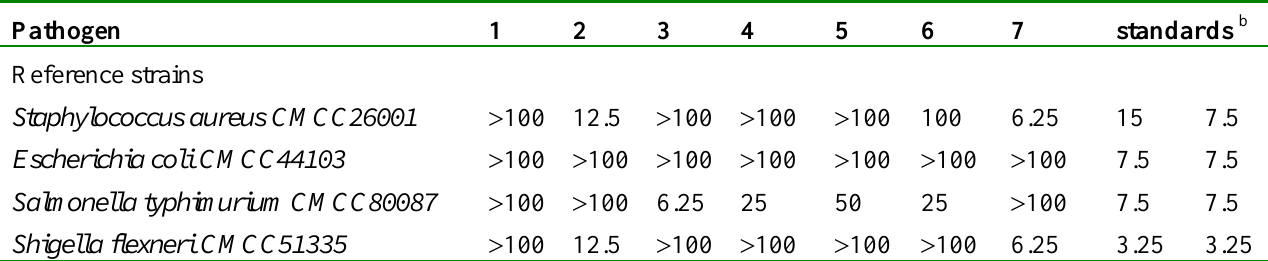
Table 2. Antibacterial activity of compounds 1-7 (MIC a values, μ